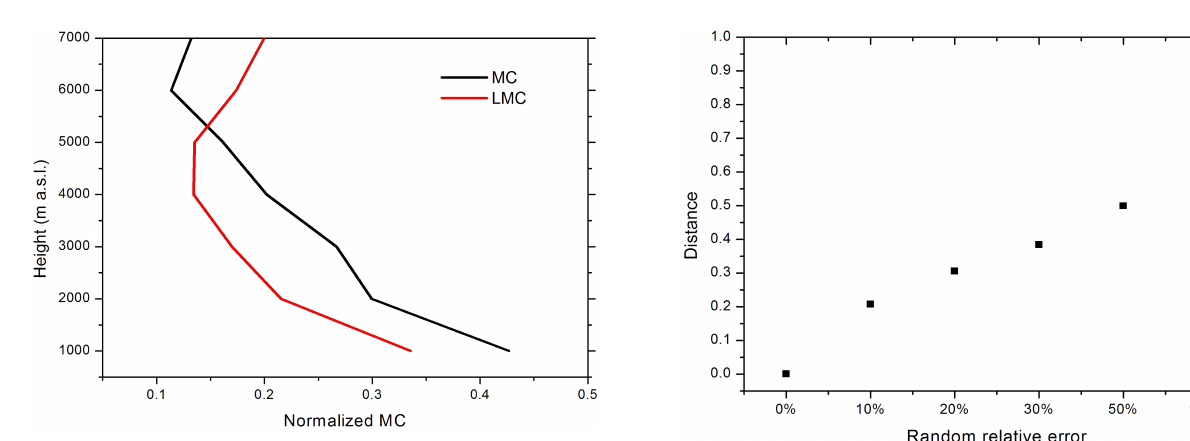
Figure 10. Statistical distance between the integrated water vapour time series retrieved from the radiosonde at the Lindenberg site and the corresponding time series obtained by adding random noise to the radiosonde time series to simulate the effect of increasing rela- tive random